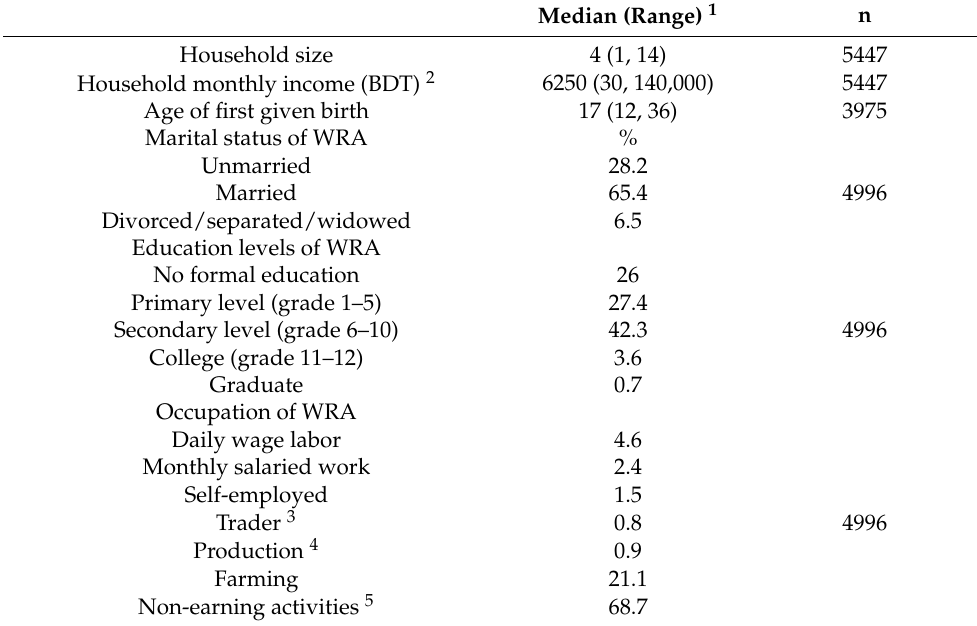
Table 1. Basic characteristics of the surveyed households and